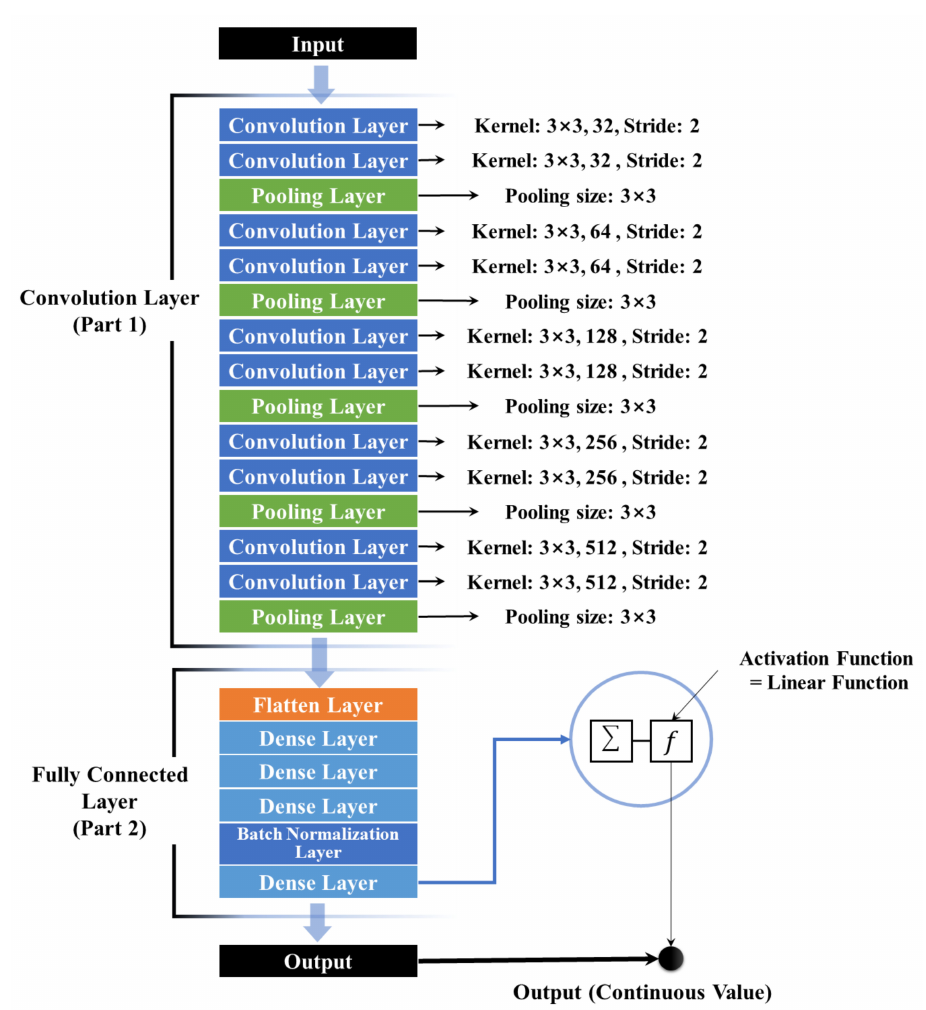
Figure 7. CNN model architecture for the simulation of the continuous variables in this study. The pooling layer, with the max and average pooling method, can efficiently utilize the computer memory and reduces computation information, resulting in the effect of preventing overfitting. As average pooling methods cause information loss, the max pooling method was used in this study. In addition, the pooling size can be arbitrarily set as in the case for the kernels; therefore, the pooling size was set to 3 × 3, identical to the kernel size. The difference between the CNN model used in this study and that of previous studies is the FC part. The CNN model employs a softmax or sigmoid function as the activation function in the last dense layer of the FC because it is designed to solve the classification problem. However, this is not suitable for the simulation of unspecified continuous variables as is the case in this study. A linear function frequently used in the regression model was applied to the last dense layer of the FC in this study, unlike previous studies. For all environments of the CNN model design, implementation, and operation, Keras [39], a machine learning library released by Google was used. Keras is a Python-based high-level deep neural network application programming interface (DNN API), with a Tensorflow [40] backend, which supports all special functions of Tensorflow and is highly flexible in implementing DNN models. Keras facilitates rapid experiments with the efficient use of the CPU and